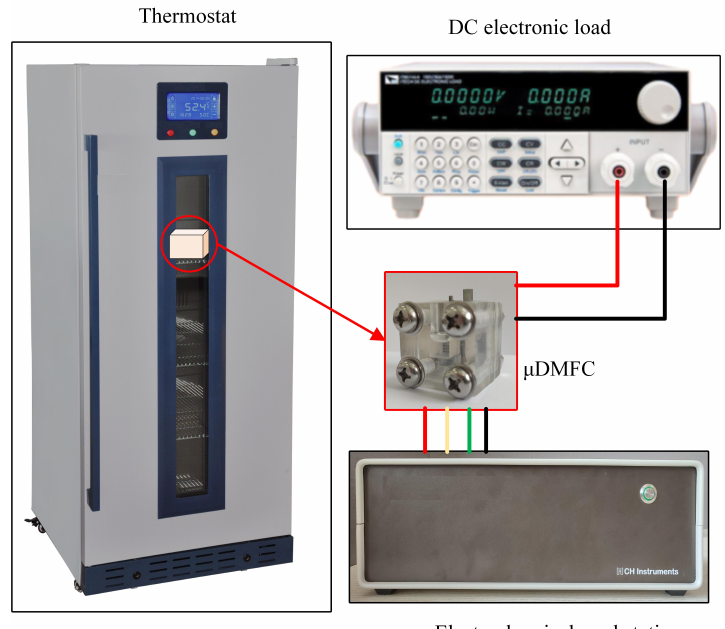
Figure 5. Test system of µ DMFC.